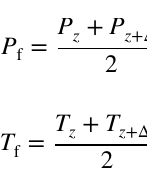
Fig. 1 A schematic of the injec- tion wellbore